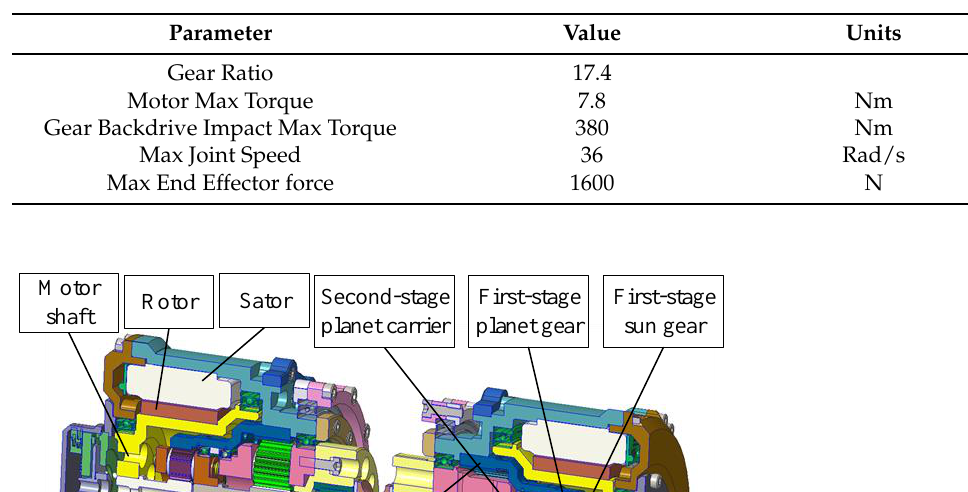
Table 1. Actuator Parameter.